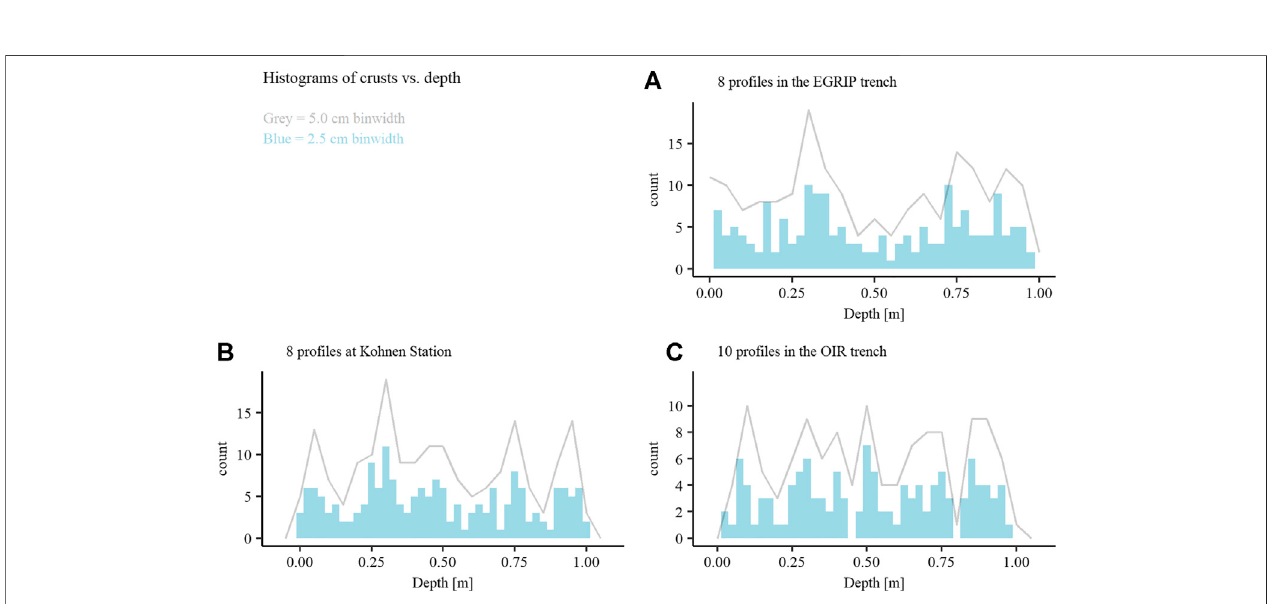
FIGURE 8 | Histograms of crusts over depth using multiple snow pro fi les (A) at EGRIP (B) at Kohnen Station and (C) at OIR camp. The blue bars are the results of using a bin width of 2.5 cm, the gray line using a bin width of 5 cm.